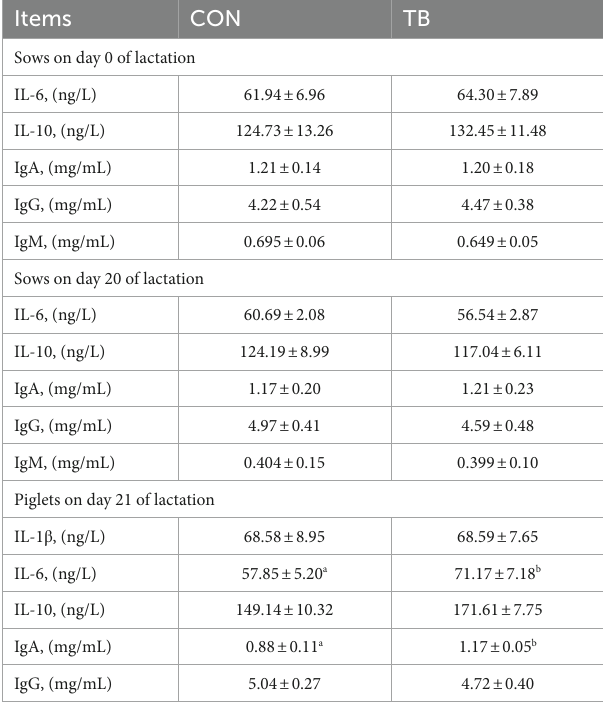
TABLE 8 Effects of tributyrin on blood hormone secretion in sows and weaned piglets.